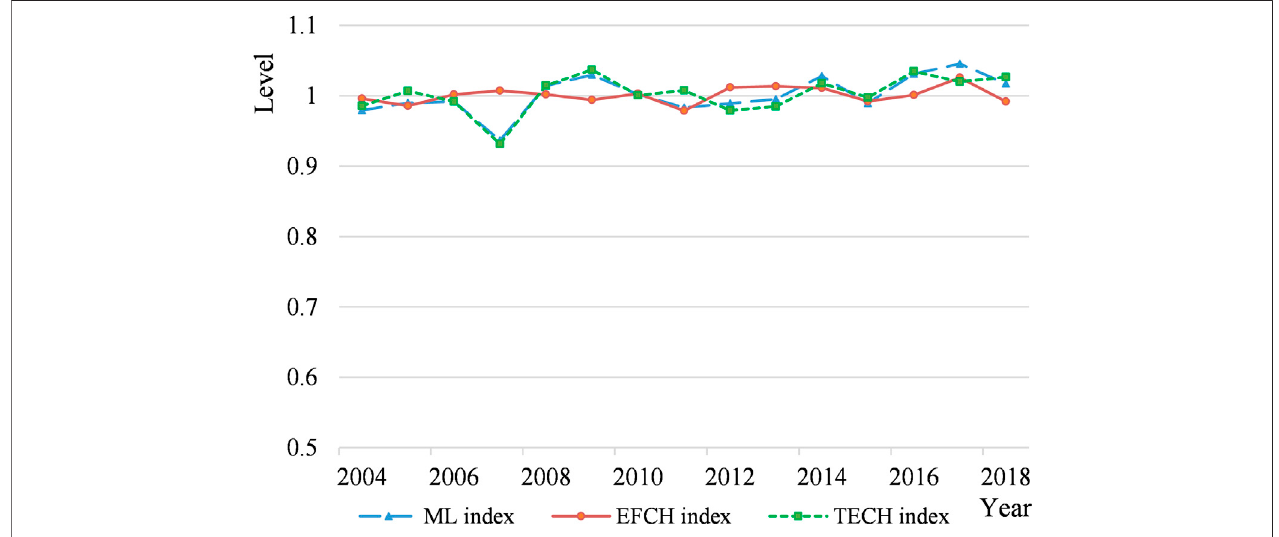
FIGURE2| AnnualchangeoftheMLindex,EFCHindex,andTECHindexintheYREBover2004 – 2018.TheMLindex,EFCHindex,andTECHindexrepresentthe GEE ’ s change, technical ef fi ciency change, and technological change, respectively. Meanwhile, the ML index is the product of the EFCH index and TECH